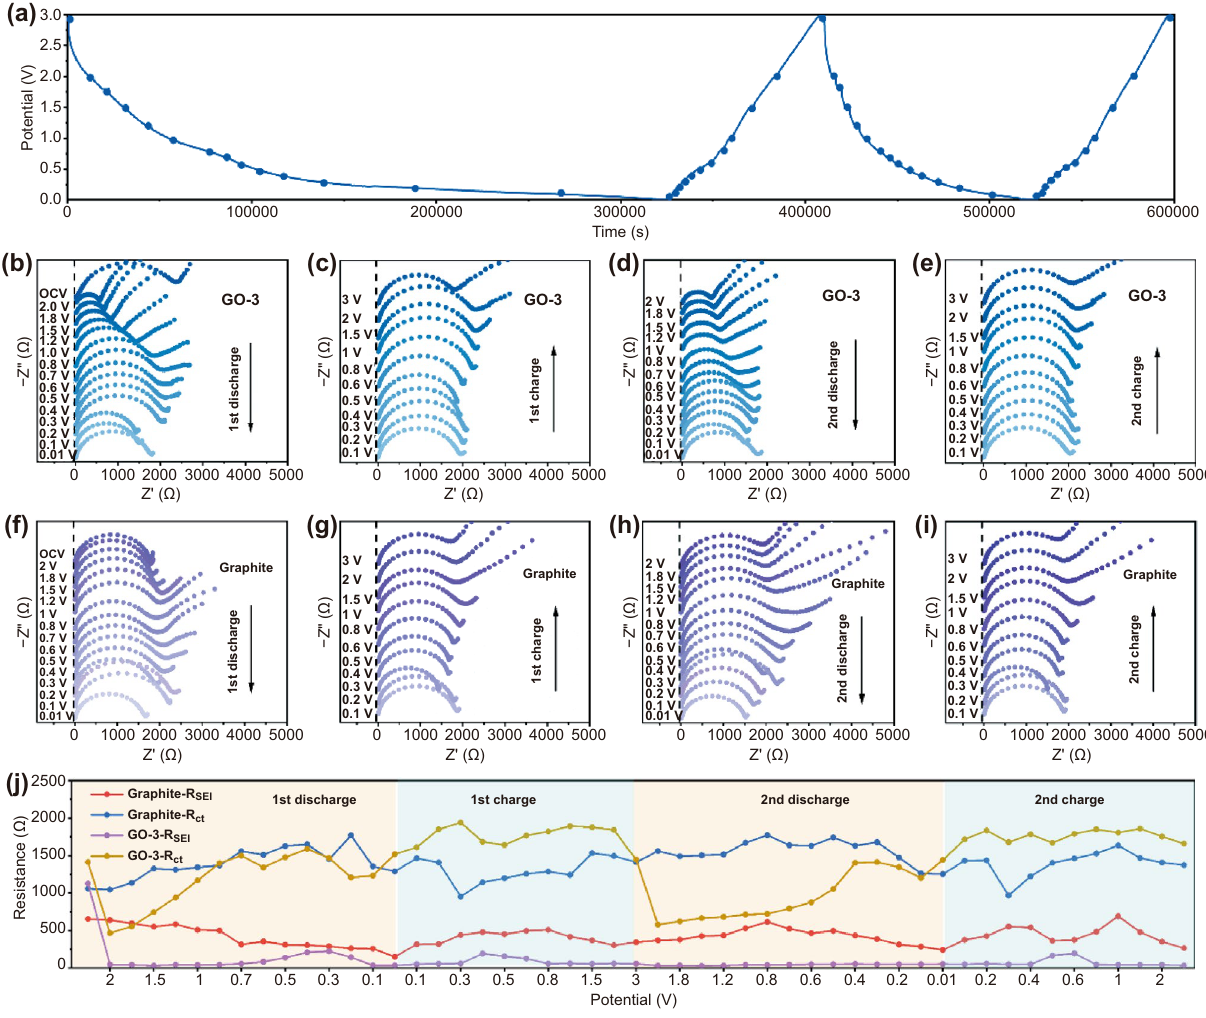
Fig. 4 In situ kinetic diagnosis during charge and discharge of graphite and GO-3. a GCD profile of GO-3 during the in situ EIS measurement. b–e Nyquist plots of GO-3 at different potentials during GCD processes. F–i Nyquist plots of graphite at different potentials during GCD pro- cesses. j Corresponding impedances at different potentials during the GCD